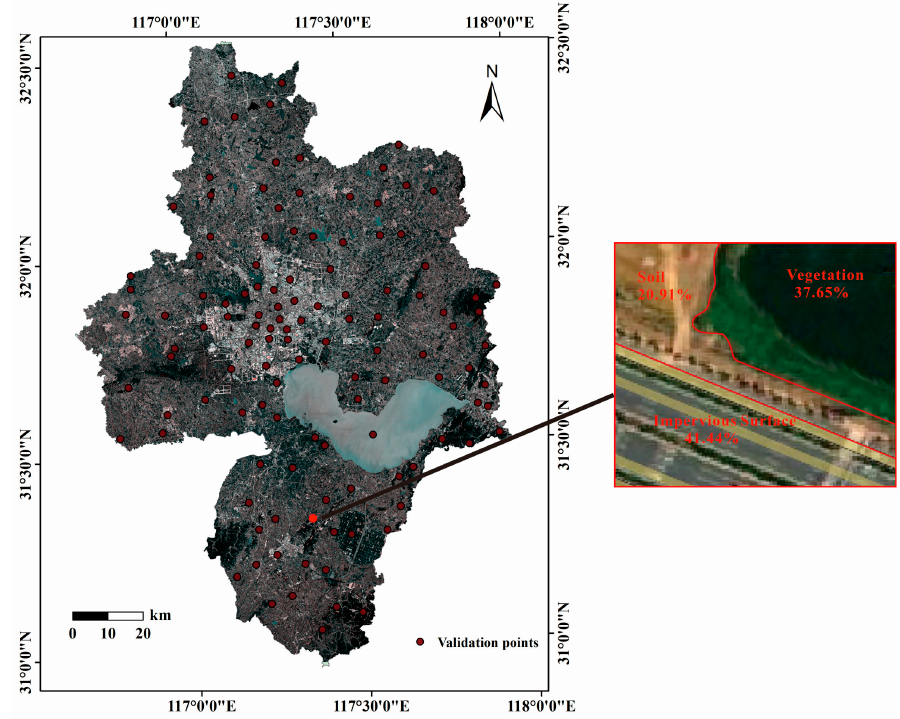
Figure 4. The proportion of each endmember in the image of validation points.